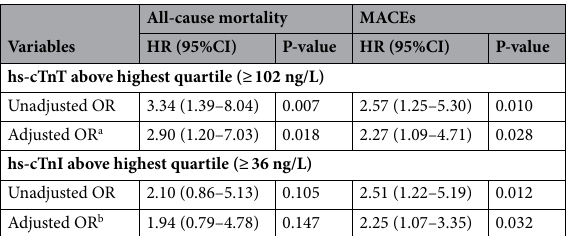
Table 2. Univariable and multivariable analysis of hs-cTnT and hs-cTnI on primary and secondary outcomes. a Adjusted for age and gender. b Adjusted for age, gender, and atrial